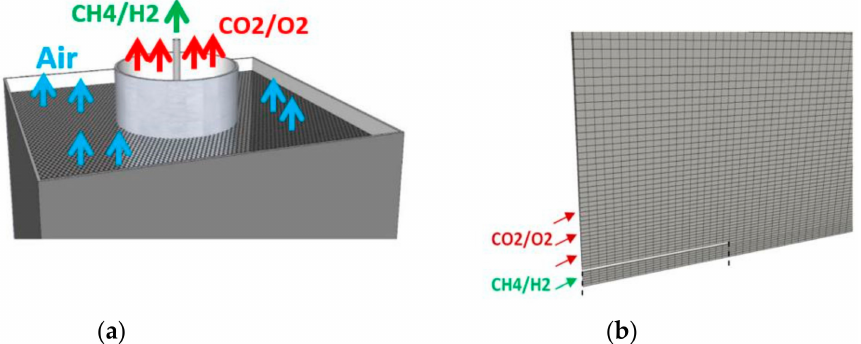
Figure 3. Oxyfuel configuration ( a ) Description of the Oxyfuel configuration according to the experimental set up in reference [28]. ( b ) Inlets part from the 2D numerical block structured